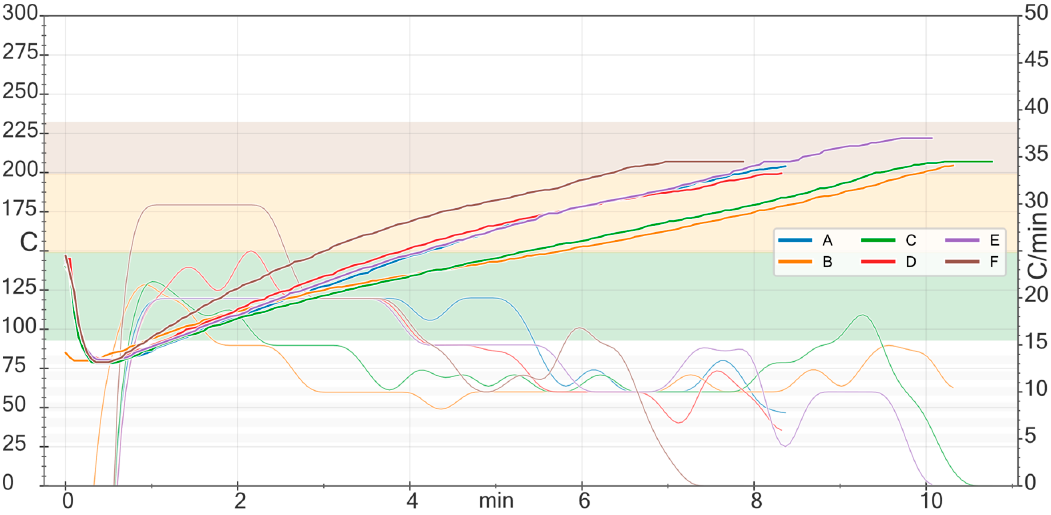
Figure 1. Profiles of experimental coffee roasting (A: Coffee quick drying; B: Coffee slow drying; C: Espresso slow drying; D: Scandinavian coffee; E: Espresso Neapolitan; F: Espresso quick drying).